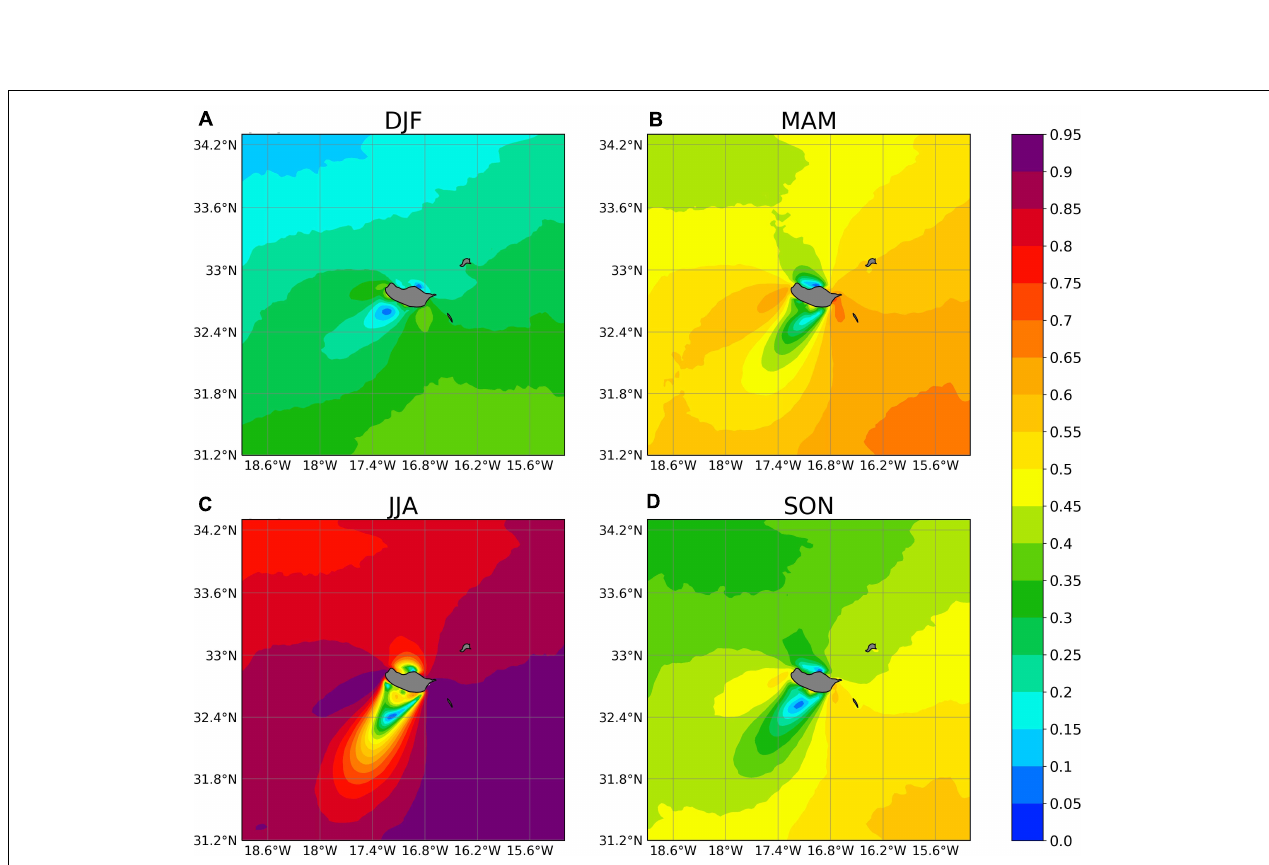
FIGURE 5 | Mean (1983–2017) [ (A) DJF, (B) MAM, (C) JJA, (D) SON] seasonal wind speed directional constancy (computed following Eq. 1).